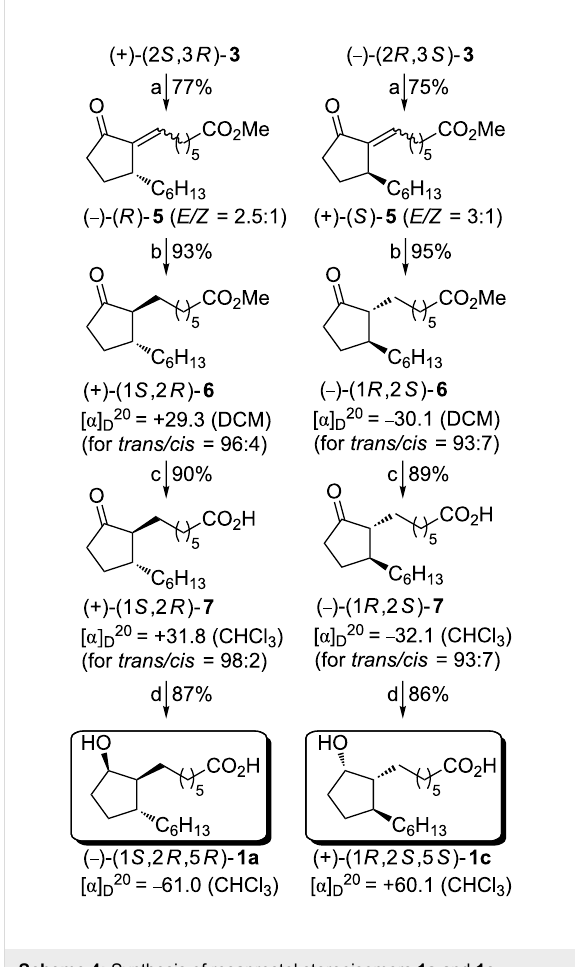
Scheme 4: Synthesis of rosaprostol stereoisomers 1a and 1c . Reagents and conditions: (a) KOH/Al 2 O 3 , OHC(CH 2 ) 5 CO 2 Me, C 6 H 6 , 3 h rt; (b) Te, NaBH 4 , EtOH, 6 h, rt; (c) 1 N NaOH, EtOH, 3 h, 45 °C; (d) L-Selectride, THF, − 75 °C, 4